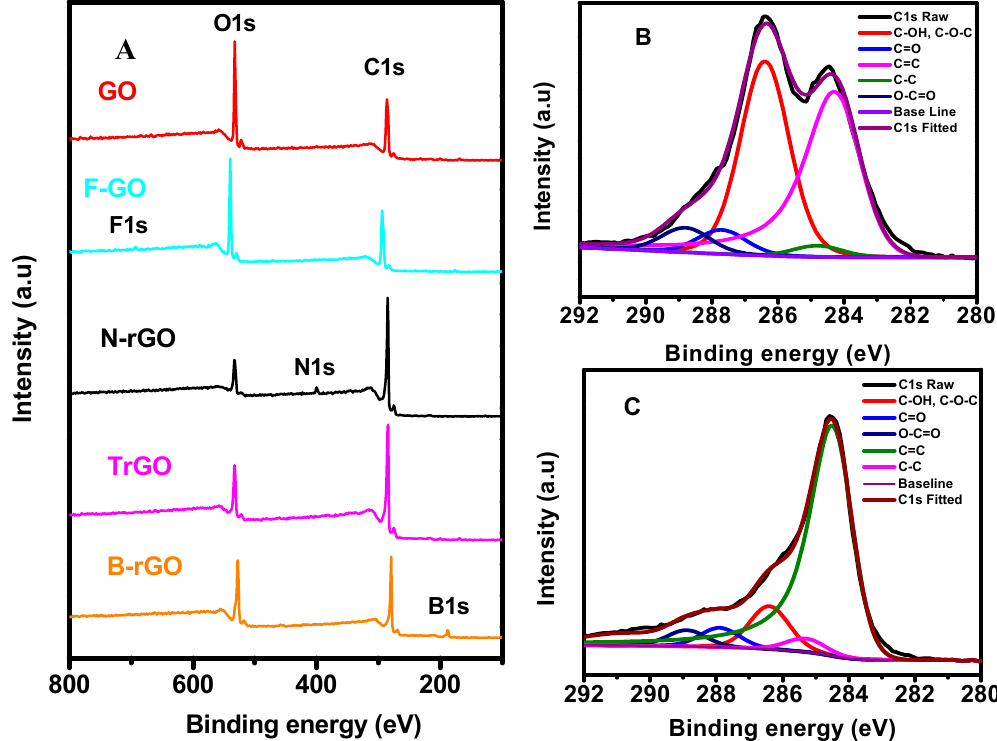
Figure 2. X-ray photoelectron spectroscopy (XPS) analysis of: ( A ) Survey spectra of graphene oxide (GO), fluorine-doped graphene oxide (F-GO), nitrogen-doped partially reduced graphene oxide (N-rGO), thermally reduced graphene oxide (TrGO), and boron-doped partially reduced graphene oxide (B-rGO). High-resolution C1s spectra with the deconvoluted peaks for ( B ) GO and ( C ) TrGO.